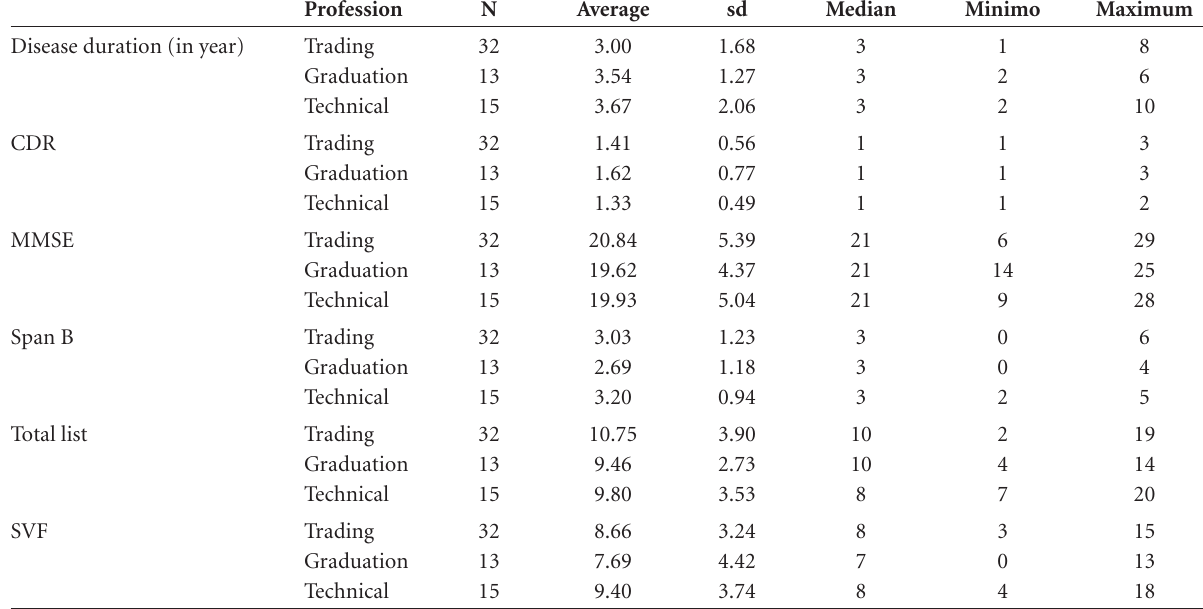
Table 3. Group I subgroups